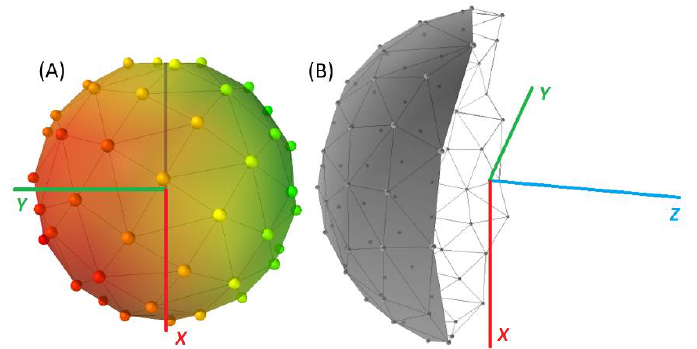
Figure 5. ( A ): Points, evenly distributed on the spherical surface. ( B ): Semi-sphere with origin orientation.